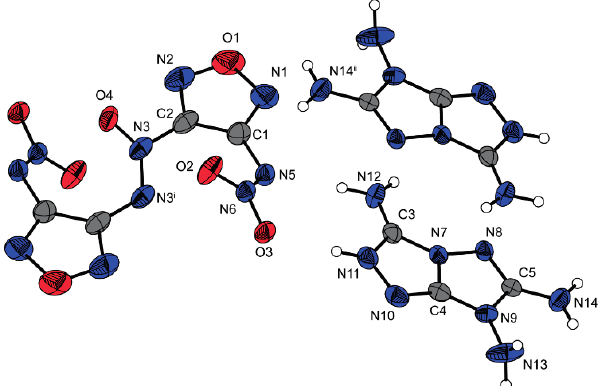
Figure 7. Molecular unit of 12 . Ellipsoids are drawn at the 50% probability level.